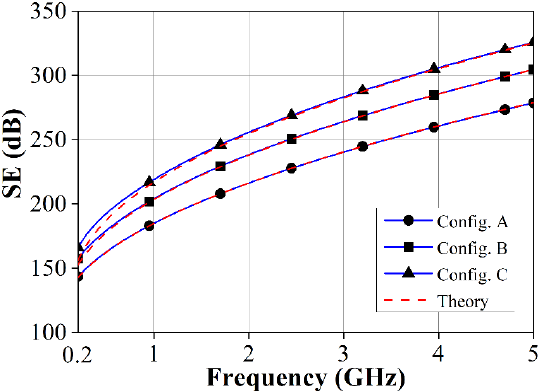
Figure 6. SE comparison between configurations A , B , C , obtained from simulation and from theory.